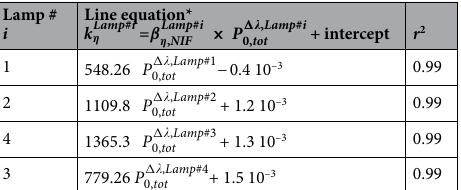
Table 2. Correlation features of NIF overall rate-constant, k η , with the total radiant power, P (cid:31) lamps used in this study (Fig. 1). *The RSD of the gradients do not exceed